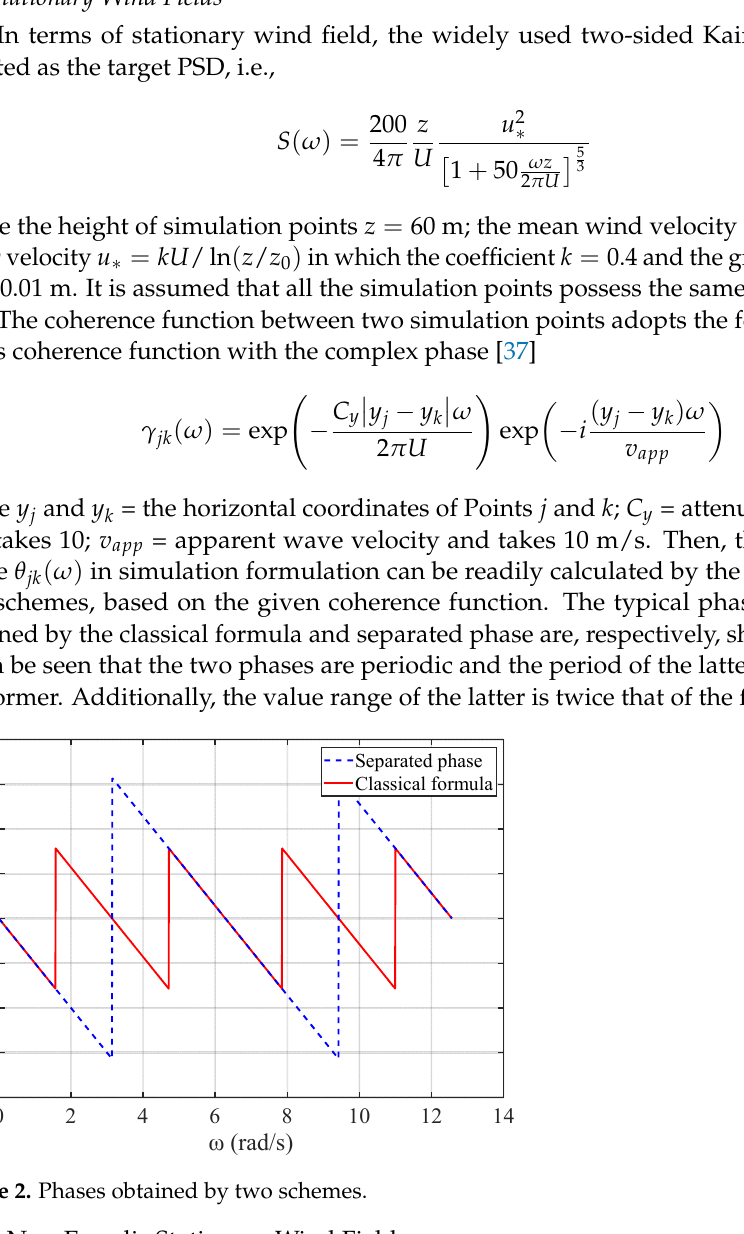
8 of 17 Figure 1. Simulation points distributed on bridge deck.